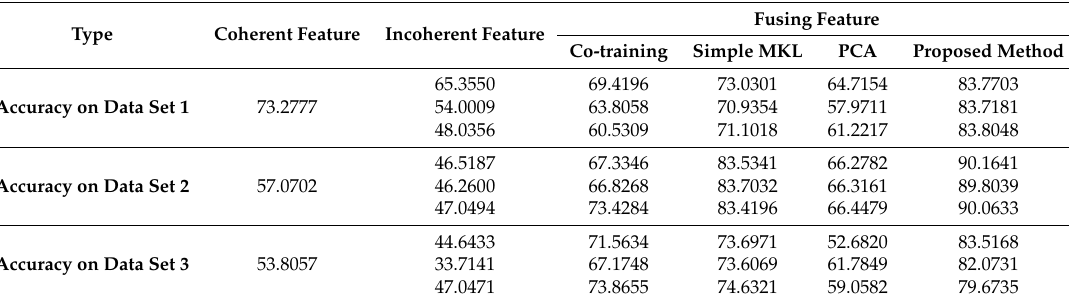
Table 1. Classification results of three data sets.